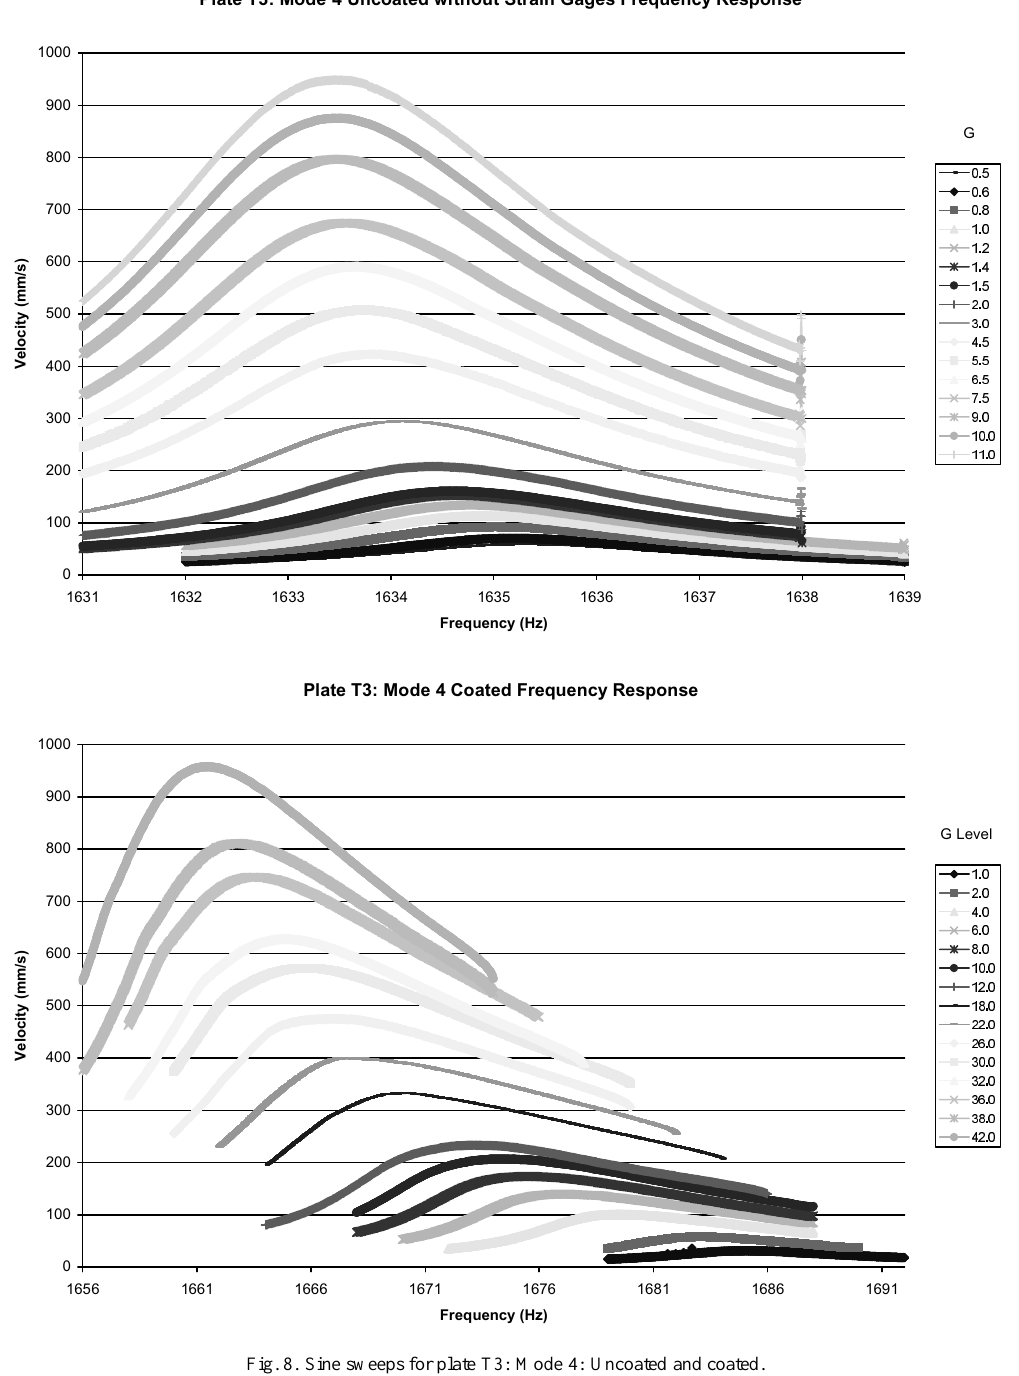
baseline for determining the damping levels provided by the mag spinel coating. Velocities of the target points, referenced to previously, were measured at this location for both modes – 2nd bend and chord wise bend – and converted to strain using the strain/displacement